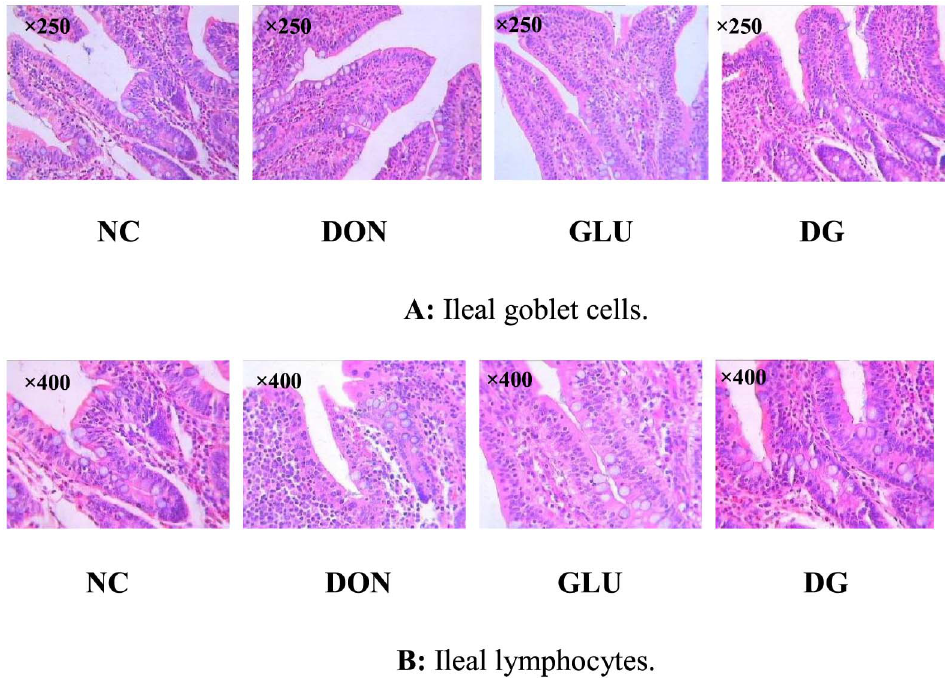
Figure 5. Image of ileal goblet cells and ileal lymphocytes. A: Ileal goblet cells ( 6 250). B: Ileam lymphocytes ( 6 400). Dietary treatments were NC, an uncontaminated basal diet, DON, the basal contaminated with 4 mg/kg deoxynivalenol, GLU, uncontaminated basal diet with 2% (g/g) glutamic acid supplementation, and DG, deoxynivalenol-contaminated (4 mg/kg) basal diet with 2% (g/g) glutamic acid supplementation. n=7 for treatments.